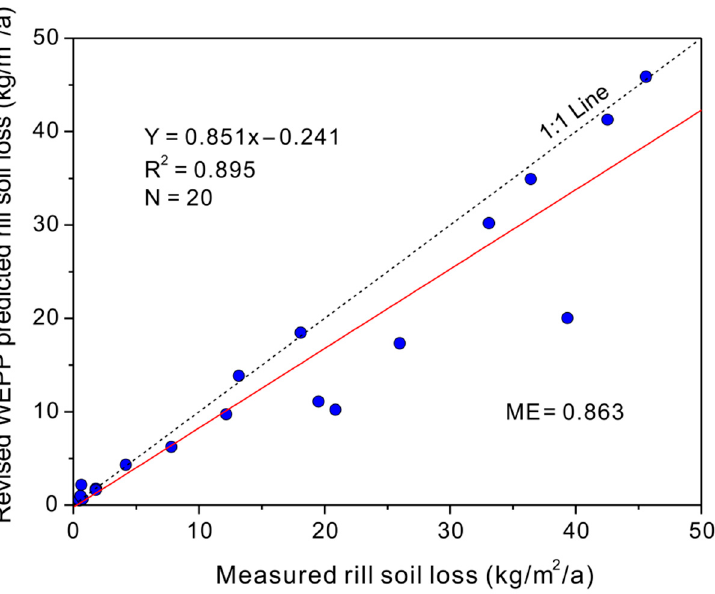
Figure 7. The measured soil loss plotted with the revised WEPP ‐ predicted soil loss rates.